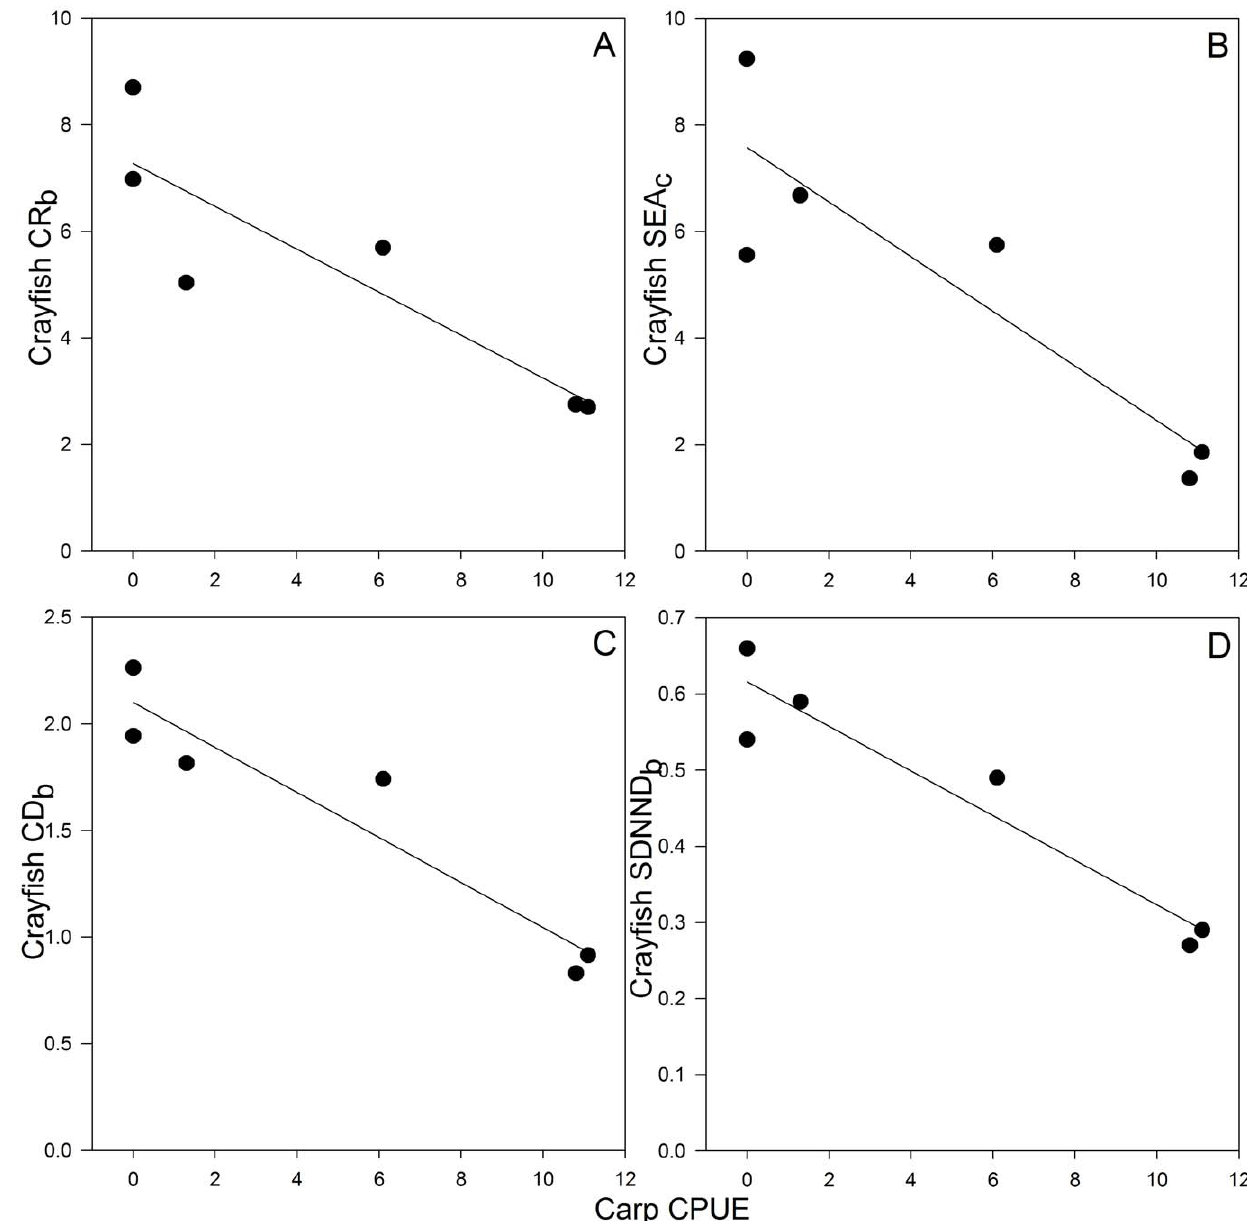
Figure 5. Relationships between carp CPUE and crayfish population metrics. A. carbon range (CR b ), B. standard ellipse area (SEA c ), C. mean distance to centroid (CD b ) and D. standard deviation of nearest neighbour distance (SDNND b ). Least-square regression lines are included for illustrative purposes only.